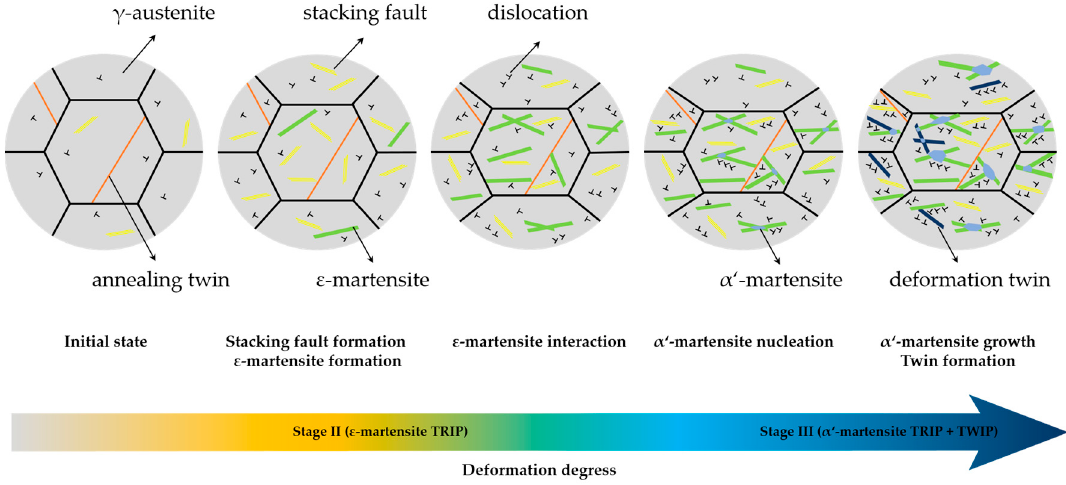
Figure 11. Schematic sketches of the microstructure evolution in Fe-17Mn-1.5Al-0.3C TRIP/TWIP steel during plastic deformation.